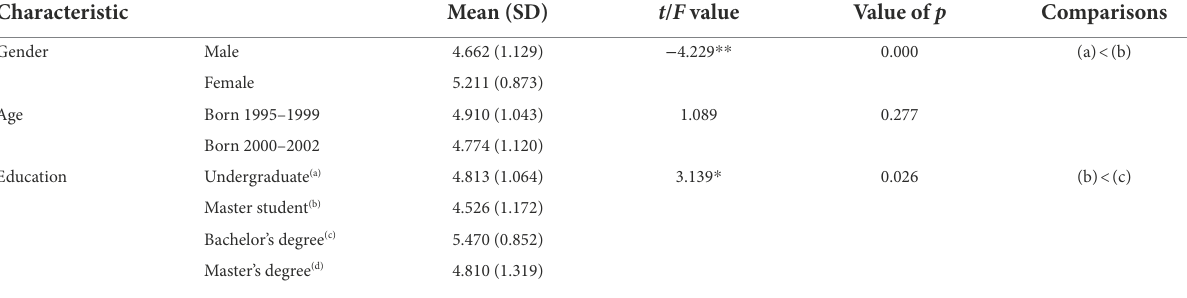
TABLE 6 Results of demographic differences in intention.